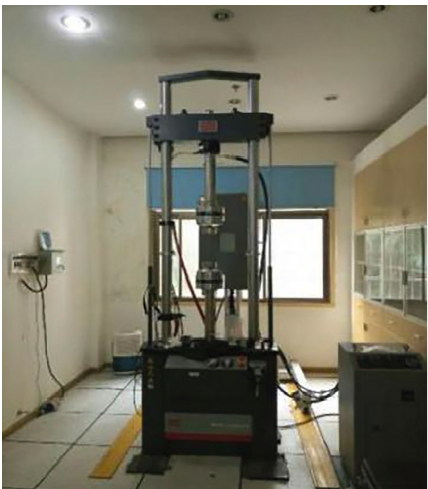
Figure 5: The MTS-Landmark testing